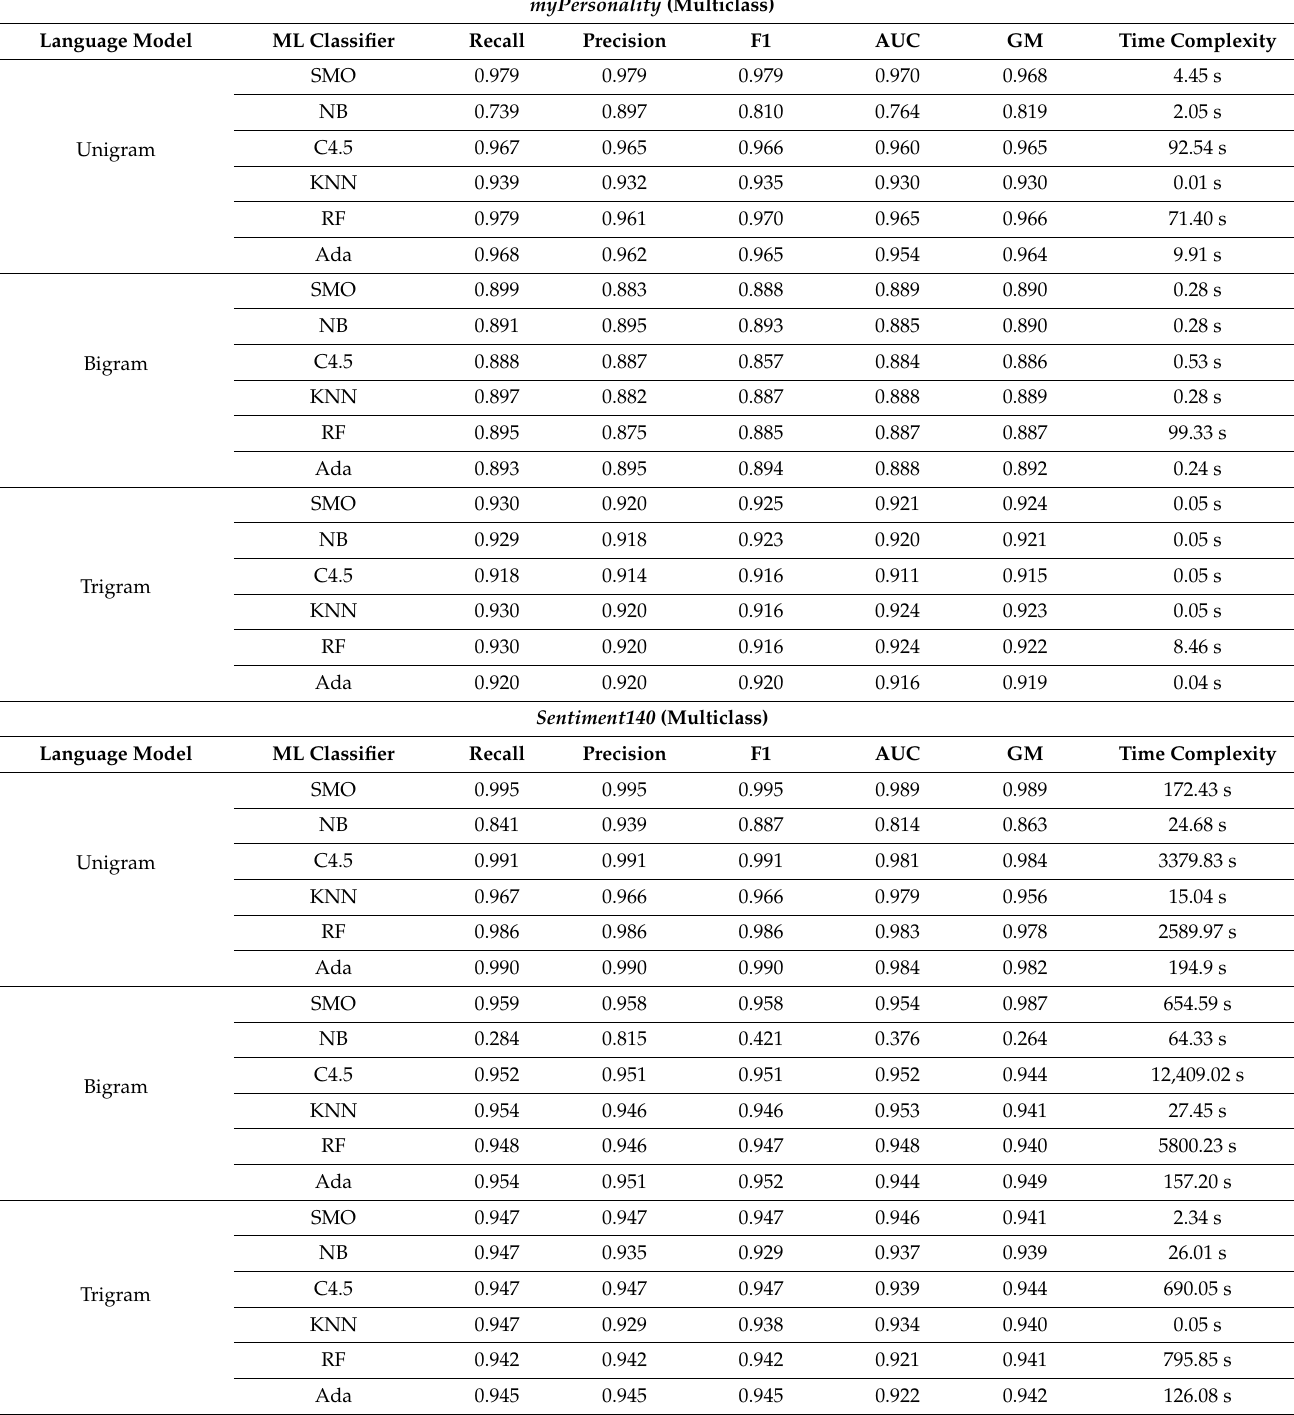
Table 9. Multiclass classification